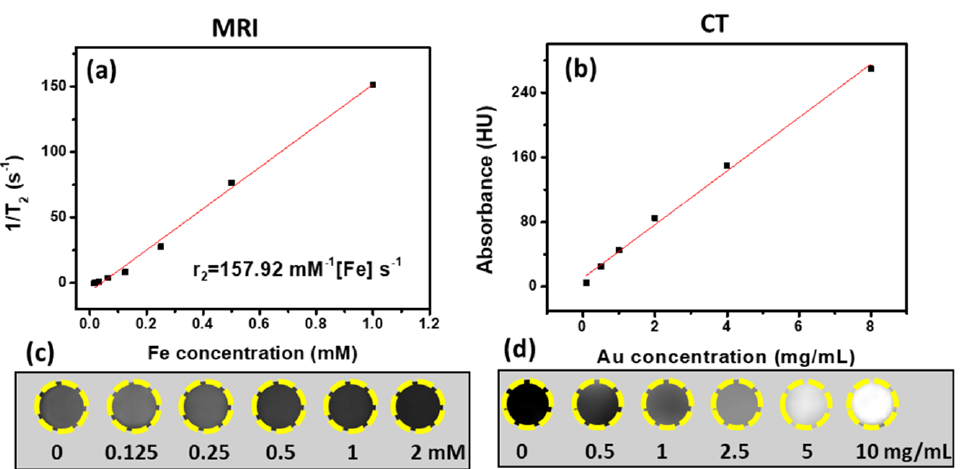
Figure 3. ( a ) Transverse relaxation rate (1/T 2 ) plot of Au-Fe 3 O 4 nanocomposites against Fe concentration. ( b ) CT attenuation plot of Au-Fe 3 O 4 nanocomposites against gold concentrations. ( c ) T 2 -weighted MR images and ( d ) CT images of Au-Fe 3 O 4 nanocomposites.